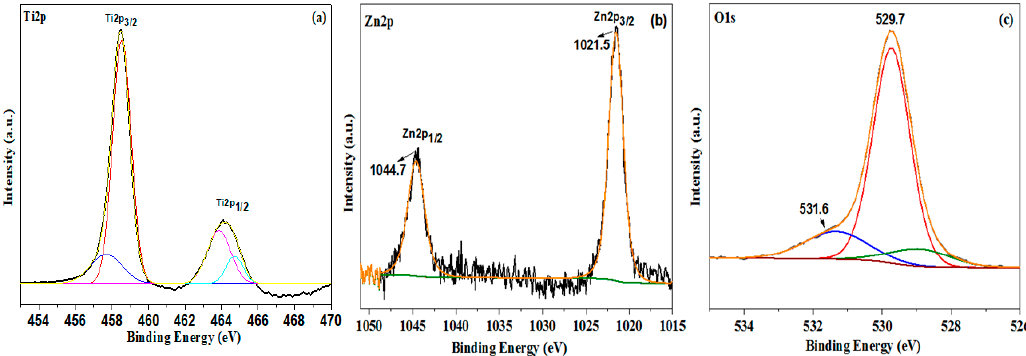
Figure 3. De-convoluted XPS spectra of ( a ) Ti2p, ( b ) Zn2p, and ( c ) O1s of Zn-TNTs nanocomposite.